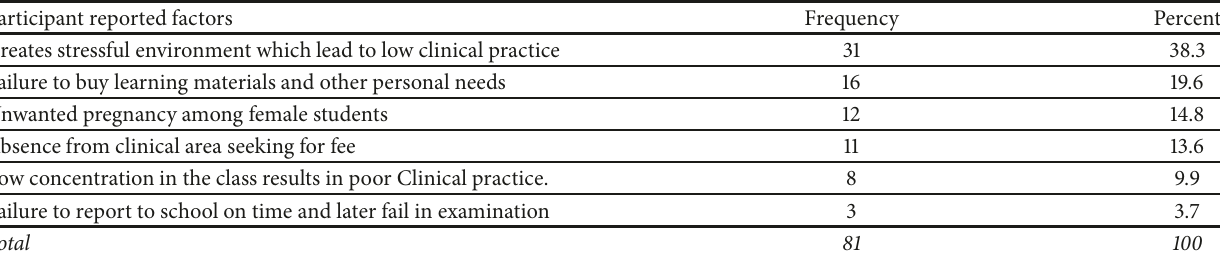
Table 8: Effects of parents’ low economic status on clinical practice (n=81).